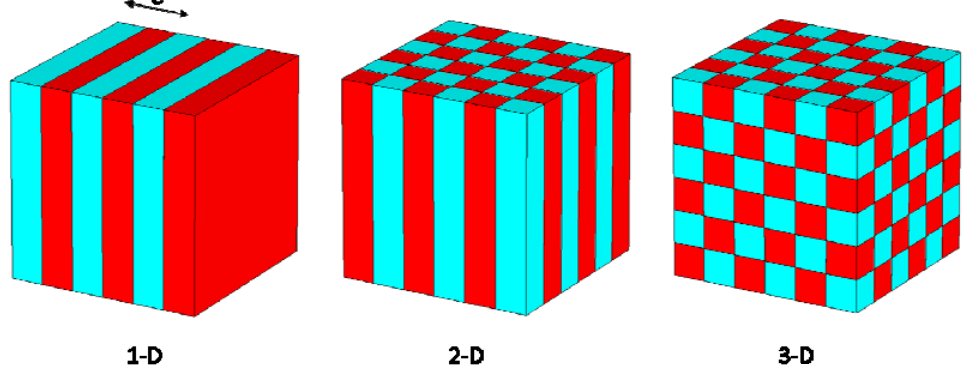
Figure 1. Schematics of a 1D, 2D and 3D photonic crystal. The colors represent materials with different dielectric indices. The spatial period of the material is called the lattice constant, c